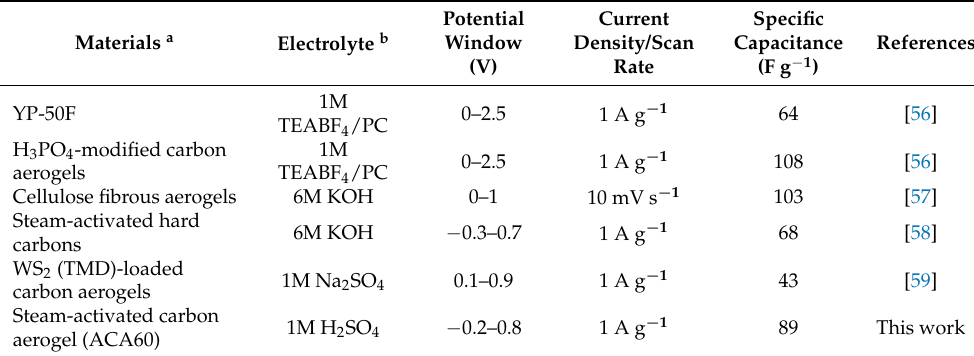
Table 3. Comparison of the specific capacitance with other